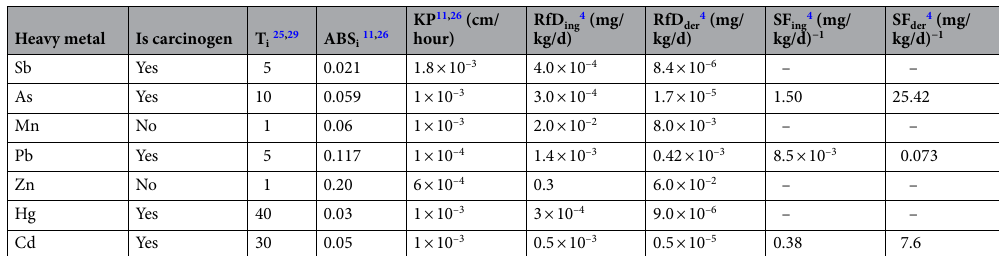
Table 1. Regulatory limits in drinking water, biological toxicity factor, gastrointestinal absorption factor of the target heavy metals, and exposure parameters. T: biological toxicity factor; ABS: absorption factor of stomach and intestines; KP: dermal permeability coefficient; RfD: reference doses; SF: the slope factors; *(Sharifi et al. 29 ; Wen et al. 25 ) **(Xiao et al. 26 ; Guo et al. 11 ) ‘–‘: No defined † (Mukherjee et al.,